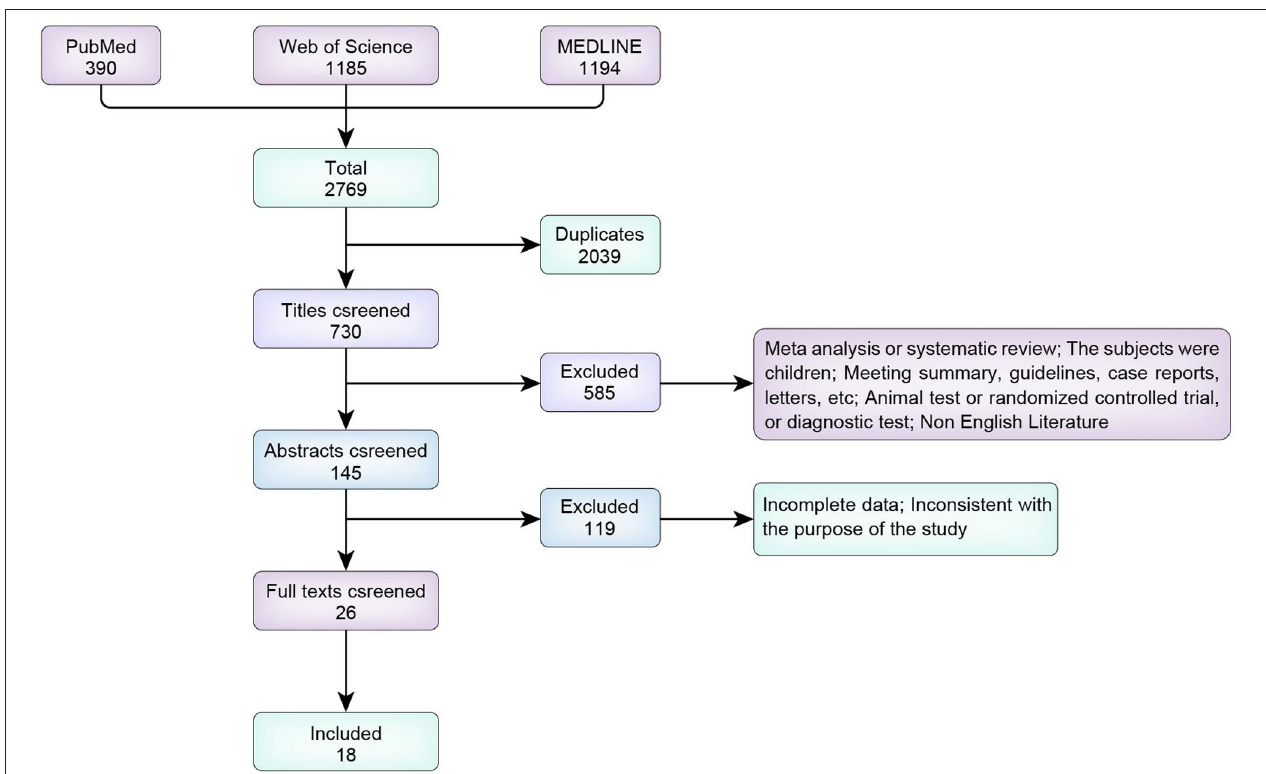
FIGURE 1 | Flow chart of study